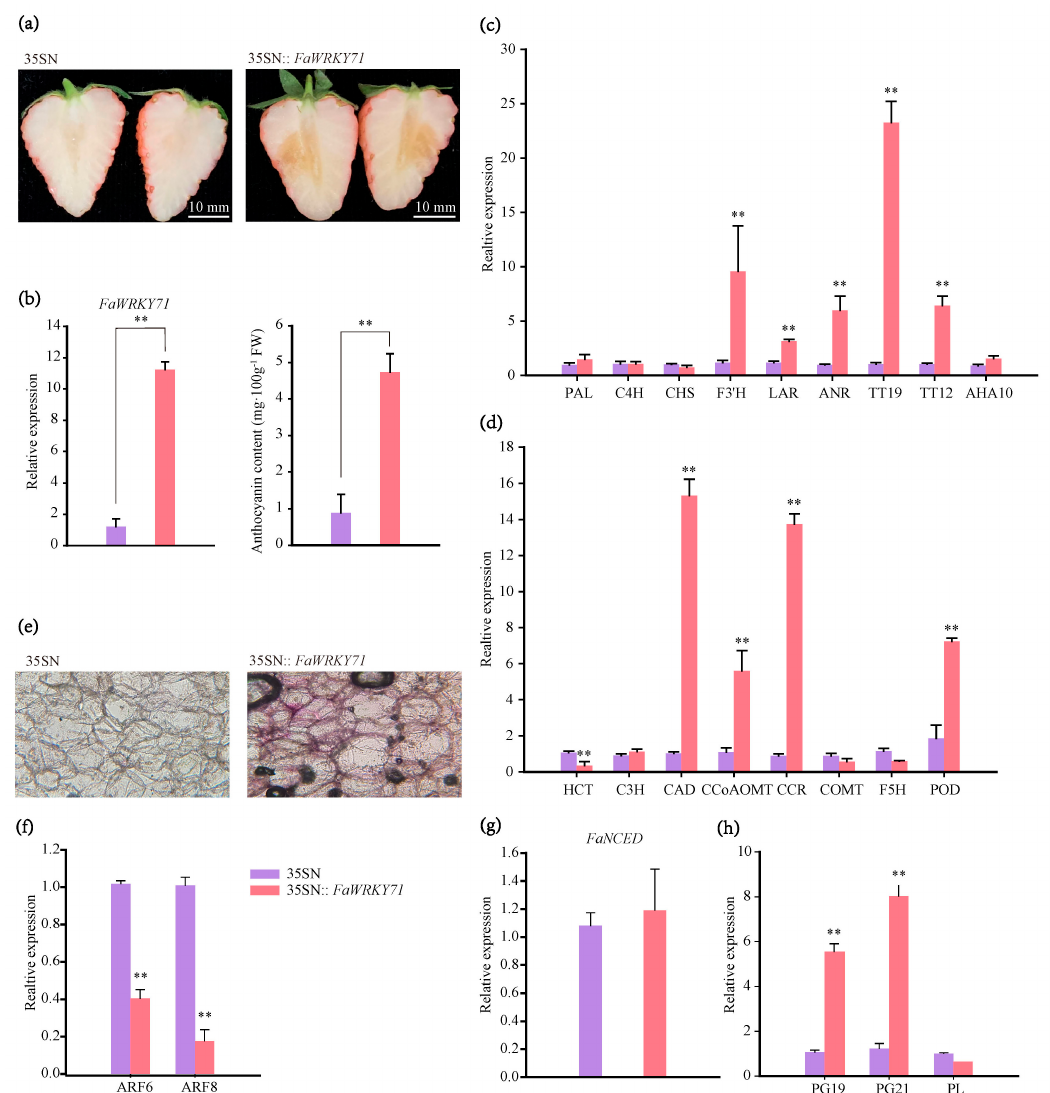
Figure 4. FaWRKY71 increased the accumulation of anthocyanin and lignin and contributed to fruit softening. (a) The phenotype of overexpressed FaWRKY71 in ‘Xiaobai’ fruit. 35SN (empty vector) was as control. Scale bars represent 10 mm. (b) Relative expression level of FaWRKY71 and antho- cyanin content in it ′ s overexpressed samples. Error bars were SEs for three replicates, and statistical significance was determined by Student’s t-test (**, P < 0.01; *, P < 0.05). (c) qRT-PCR analysis of key structural genes and transport factors in the flavonoid biosynthesis pathway. Phenylalanine ammonia lyase ( PAL ); cinnamate 4-hydroxylase ( C4H ); chalcone synthase ( CHS ); flavonoid 3 ′ -hydroxylase ( F3 ′ H ); leucoanthocyanidin reductase ( LAR ); anthocyanidin reductase ( ANR ); TRANSPARENT TESTA 19 ( TT19 ); TRANSPARENT TESTA 12 ( TT12 ); H + -ATPase 10 ( AHA10 ). (d) qRT-PCR analysis of key structural genes of lignin pathway. shikimate O-hydroxycinnamoyl transferase ( HCT ); coumarate 3-hydroxylase ( C3H ); cinnamyl alcohol dehydrogenase ( CAD ); caffeoyl CoA O-methyl transferase ( CCoAOMT ); cinnamoyl CoA reductase ( CCR ); caffeic acid O-methyltransferase ( COMT ); ferulate 5-hydroxylase ( F5H ); peroxidase ( POD ). (e) Safranin-stained section of strawberry fruit. The lignified cell walls were dyed red. (f-h) The expression levels of ARF , NCED , PG , and PL in FaWRKY71 overexpressed samples.